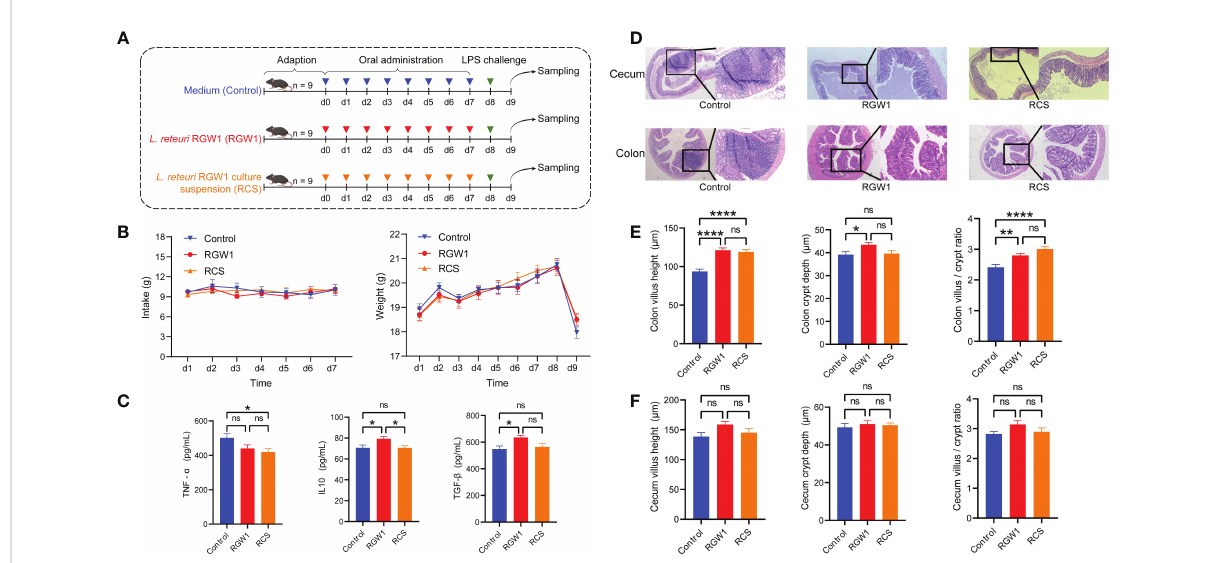
FIGURE 3 Immunomodulatory effects of L. reuteri RGW1 on in fl ammation in mice challenged with LPS. (A) Experimental schedule for LPS challenge and administration of L. reuteri RGW1 and RCS. LPS was intraperitoneally injected on day 8, L. reuteri RGW1 or RCS was orally administrated 7 times. (B) The intake and weight of mice. (C) The levels of serum IFN- a , TGF- b and IL-10. (D) Representative images of the colon stained with H&E. (E, F) Intestinal morphology analysis based on measurements of the villus height, crypt depth, and the ratio of villus height to crypt depth (VH/ CD) in colon or cecum tissues. Values are expressed as means ± SEM. *P < 0.05; **P < 0.01; ****P < 0.0001; ns, not signi fi